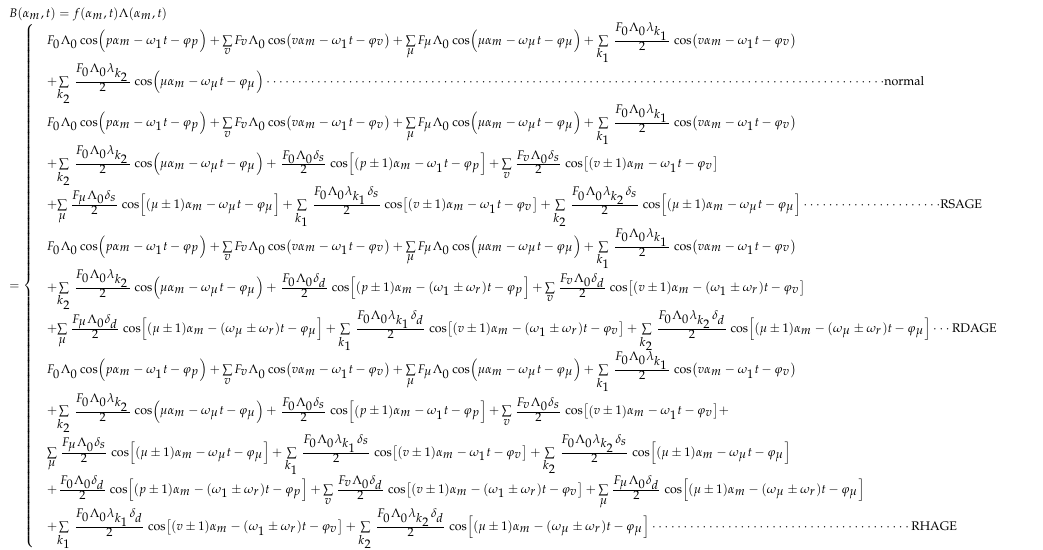
According to Equation (7), RSAGE introduces extra MFD harmonic components, whose spatial coefficients are p ± 1, v ± 1, and µ ± 1, and the corresponding frequencies are ω 1 , ω 1 , and ω µ . The stator winding adopts a double Y-shaped connection, and each